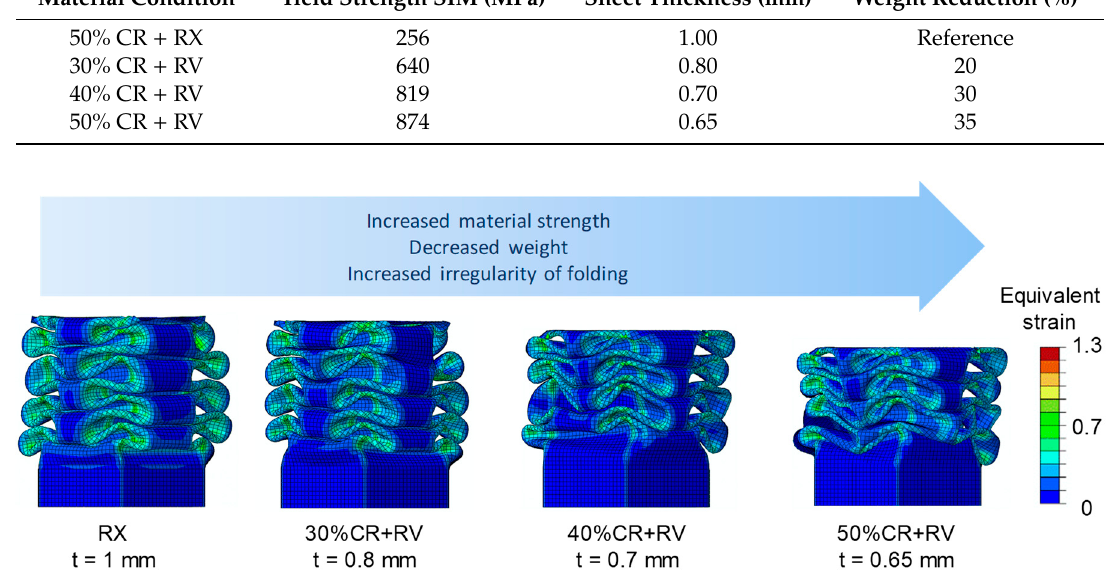
Figure 8. Final crash box geometry after crash simulation for individual t for each material condition.